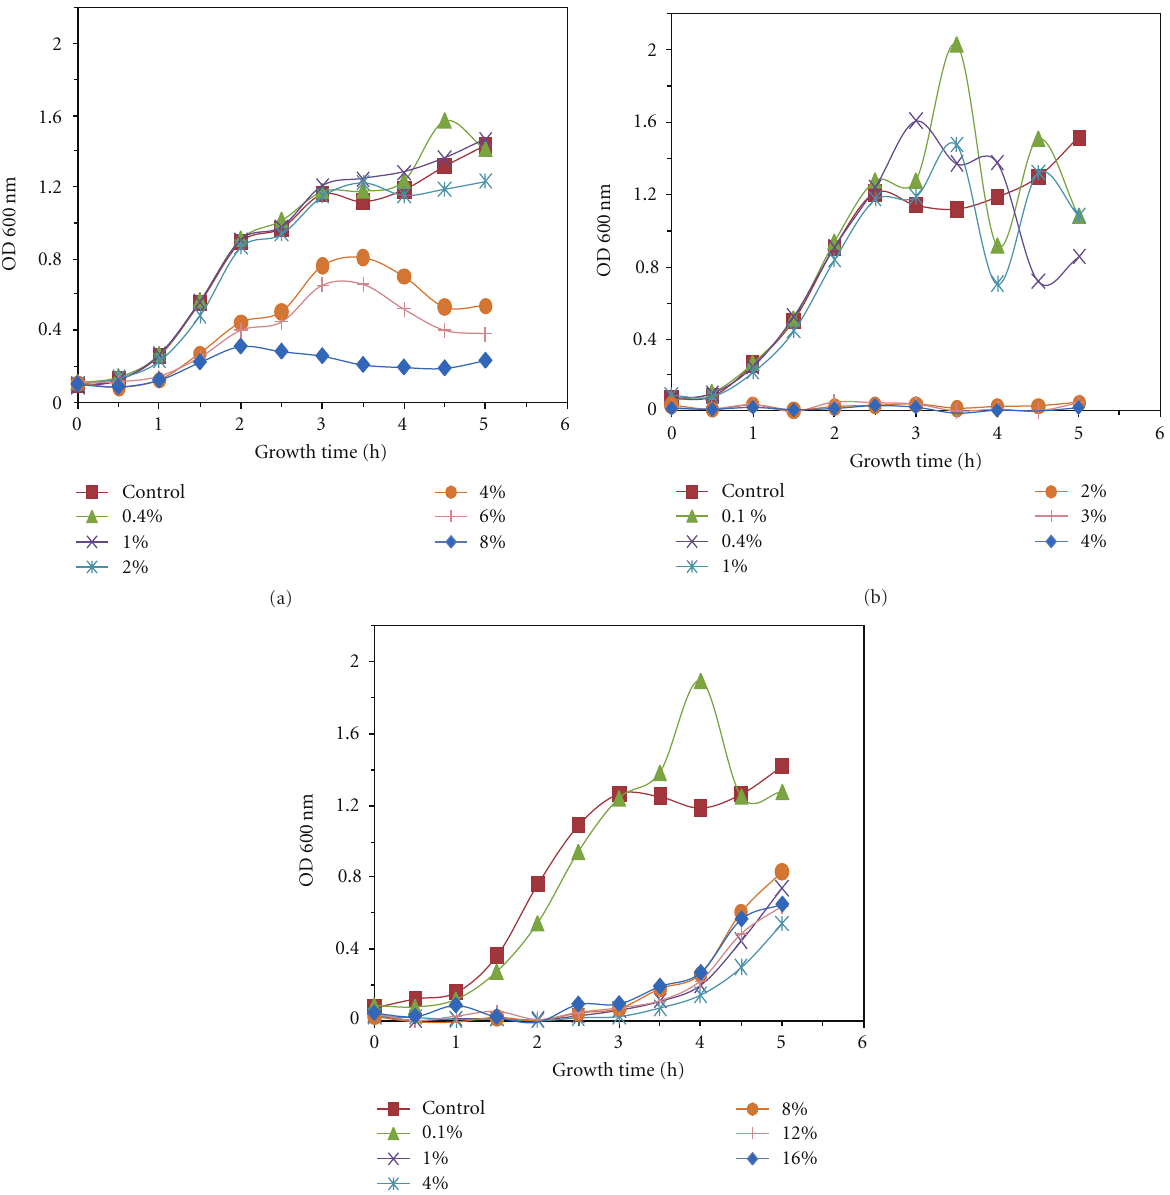
Figure 2: OD growth curves of E. coli after treatment with surfactant-only solutions and incubation for 1h: (a) treated with 0.4, 1, 2, 4, 6, and 8% SC; (b) treated with 0.1, 0.4, 1, 2, 3, and 4% SDBS, and (c) treated with 0.1, 1, 4, 8, 12, and 16% SDS. Other conditions are the same as in Figure